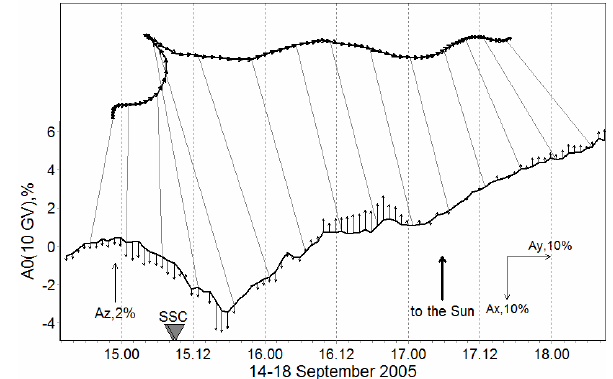
Figure 2: Behavior of the CR density ( А 0) and vector of equatorial component of the anisotropy ( Ах y) for 10 GV rigidity CR during September 9-13, 2005. Vertical vectors represent the north-south component of the CR anisotropy. Triangles indicate the timing of the shock arriving. The thin lines connect the equal time moments on the density curve with the vector diagram.